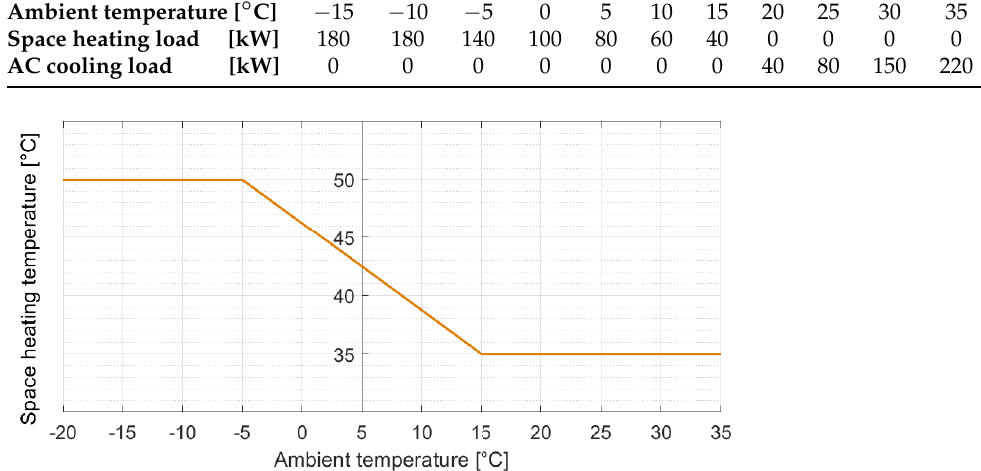
Figure 5. Set point curve for hydronic circuit for space heating depending on ambient